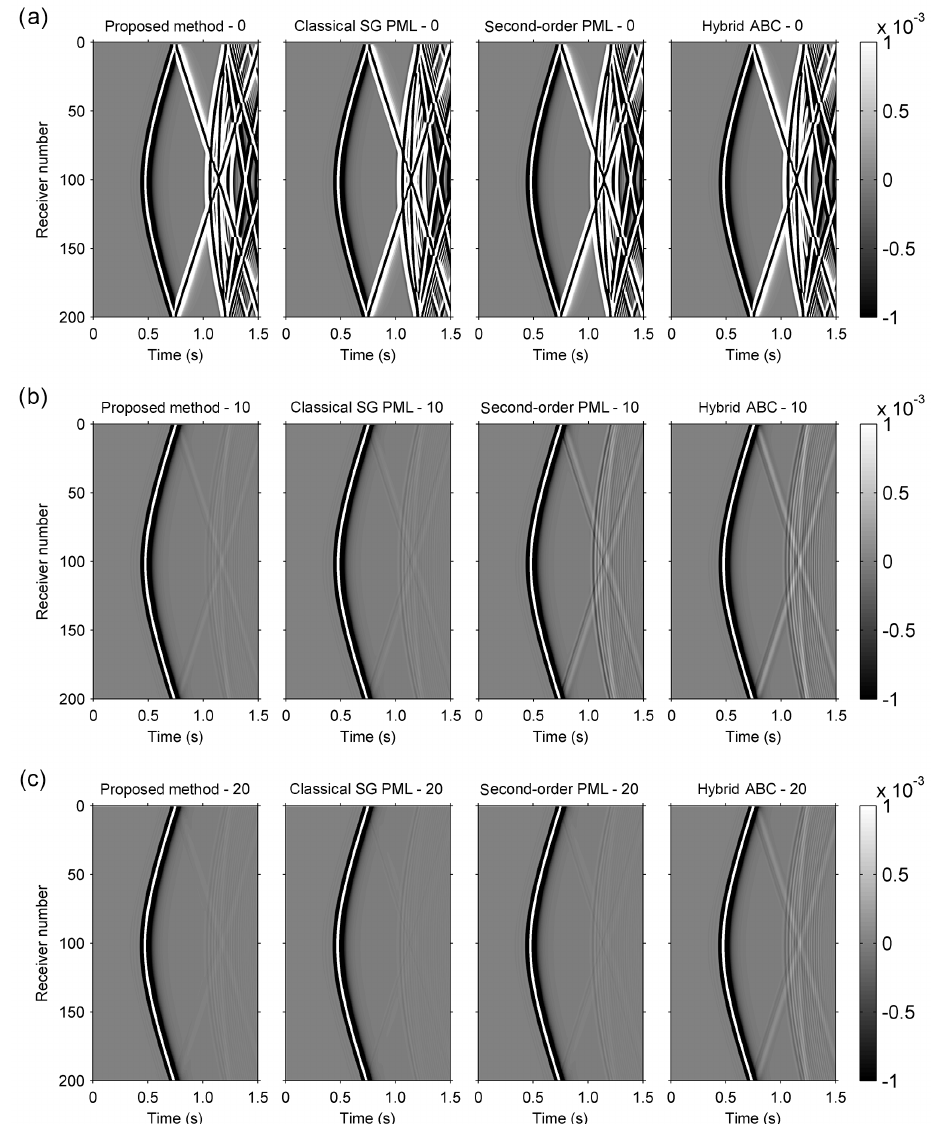
Figure 15. Receiver records for the four methods for a different number of absorbing layers: (a) 0 absorbing layers, (b) 10 absorbing layers, and (c) 20 absorbing